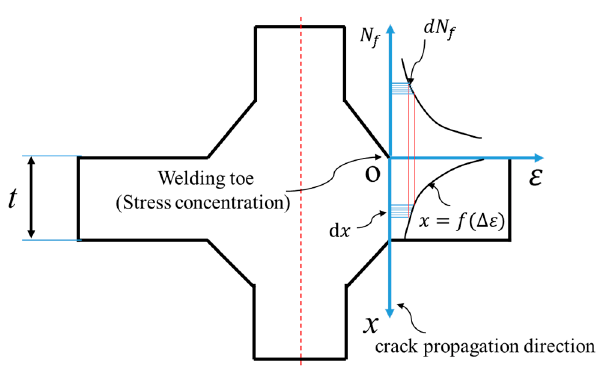
Figure 3. Cross section of cruciform joint with high stress concentration at the weld toe.